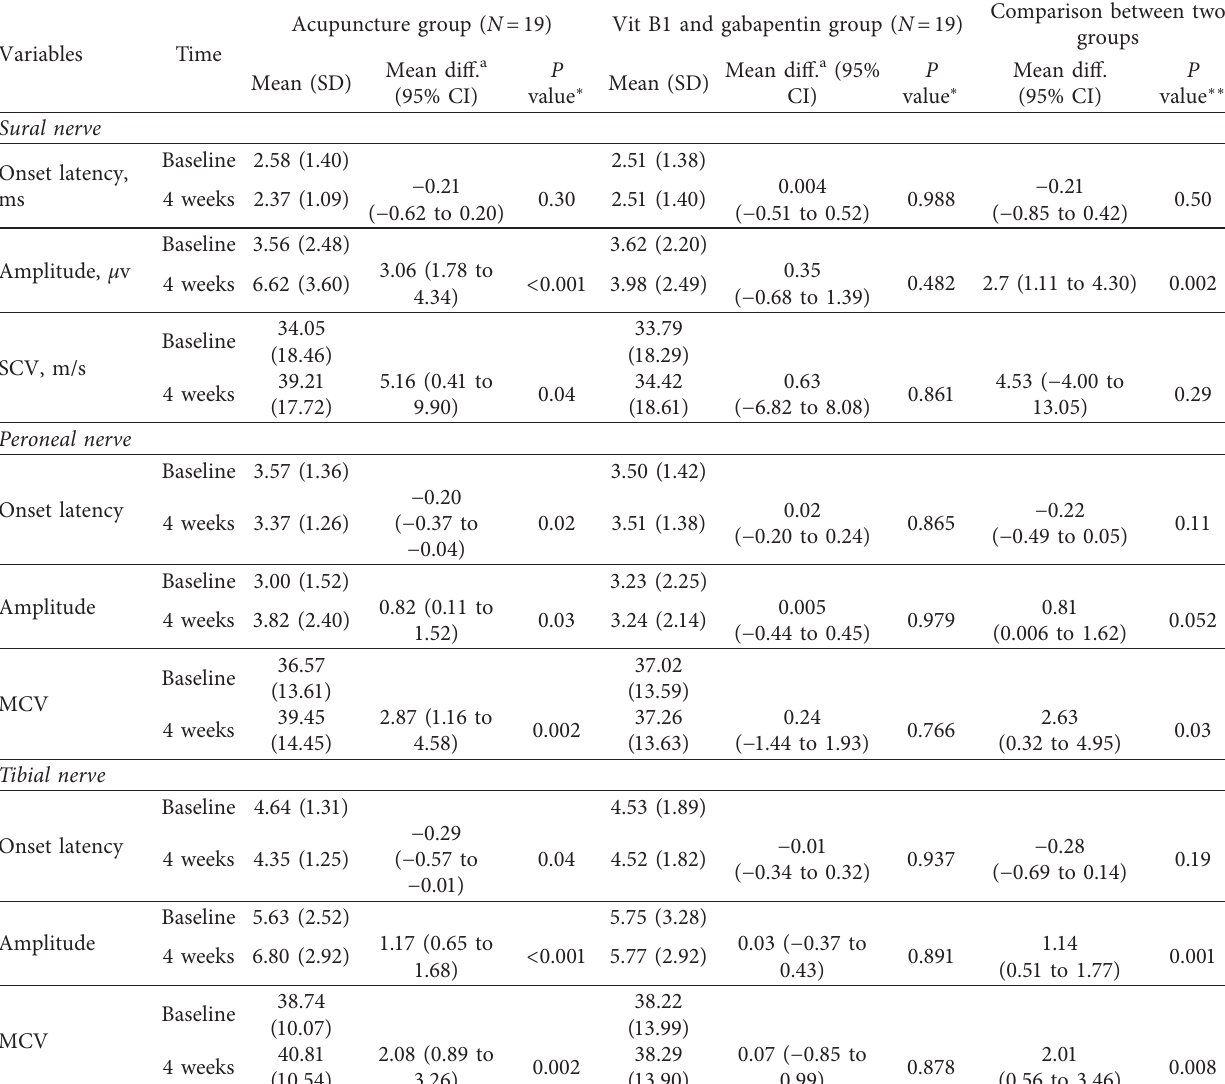
Table 4: Comparison of changes of NCS within and between groups.